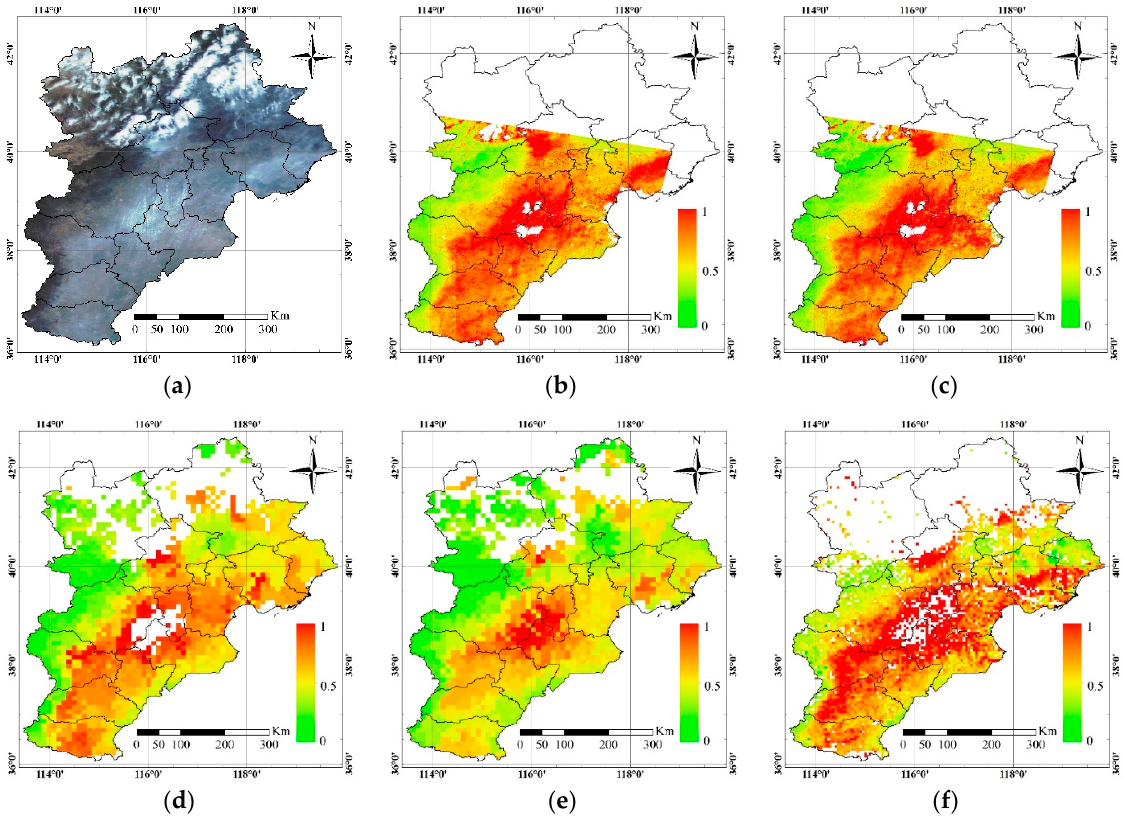
Figure 9. AOD spatial distribution on 12 July 2017. ( a ) Terra/MODIS true color image, ( b ) GF-1/WFV AOD_WORT, ( c ) GF-1/WFV AOD_WMRT, ( d ) Terra/MODIS AOD_MODT, ( e ) Terra/MODIS AOD_MODB, and ( f ) Himawari-8/AHI AOD_AHI.